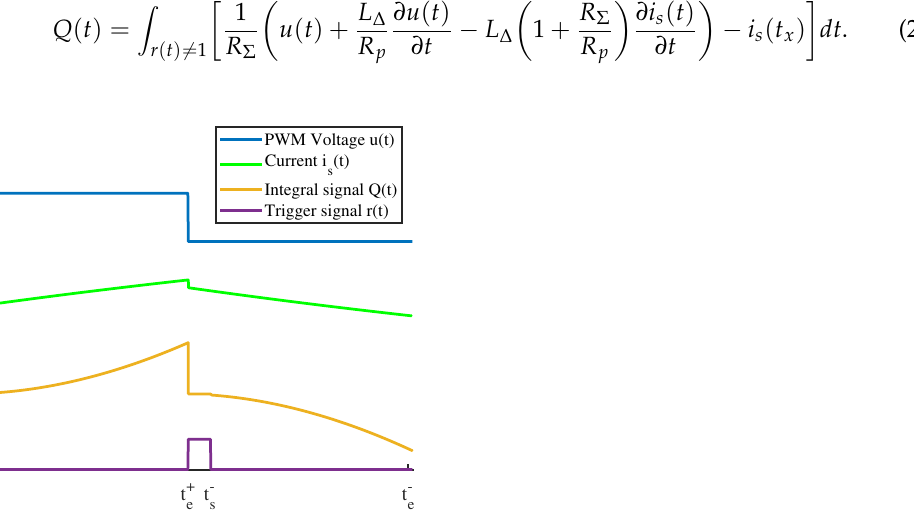
Figure 9. Applied PWM voltage u ( t ) , resulting current i s ( t ) , trigger signal r ( t ) as well as output of the IDIM circuit Q ( t ) , schematically shown for the defined trigger times, adopted from